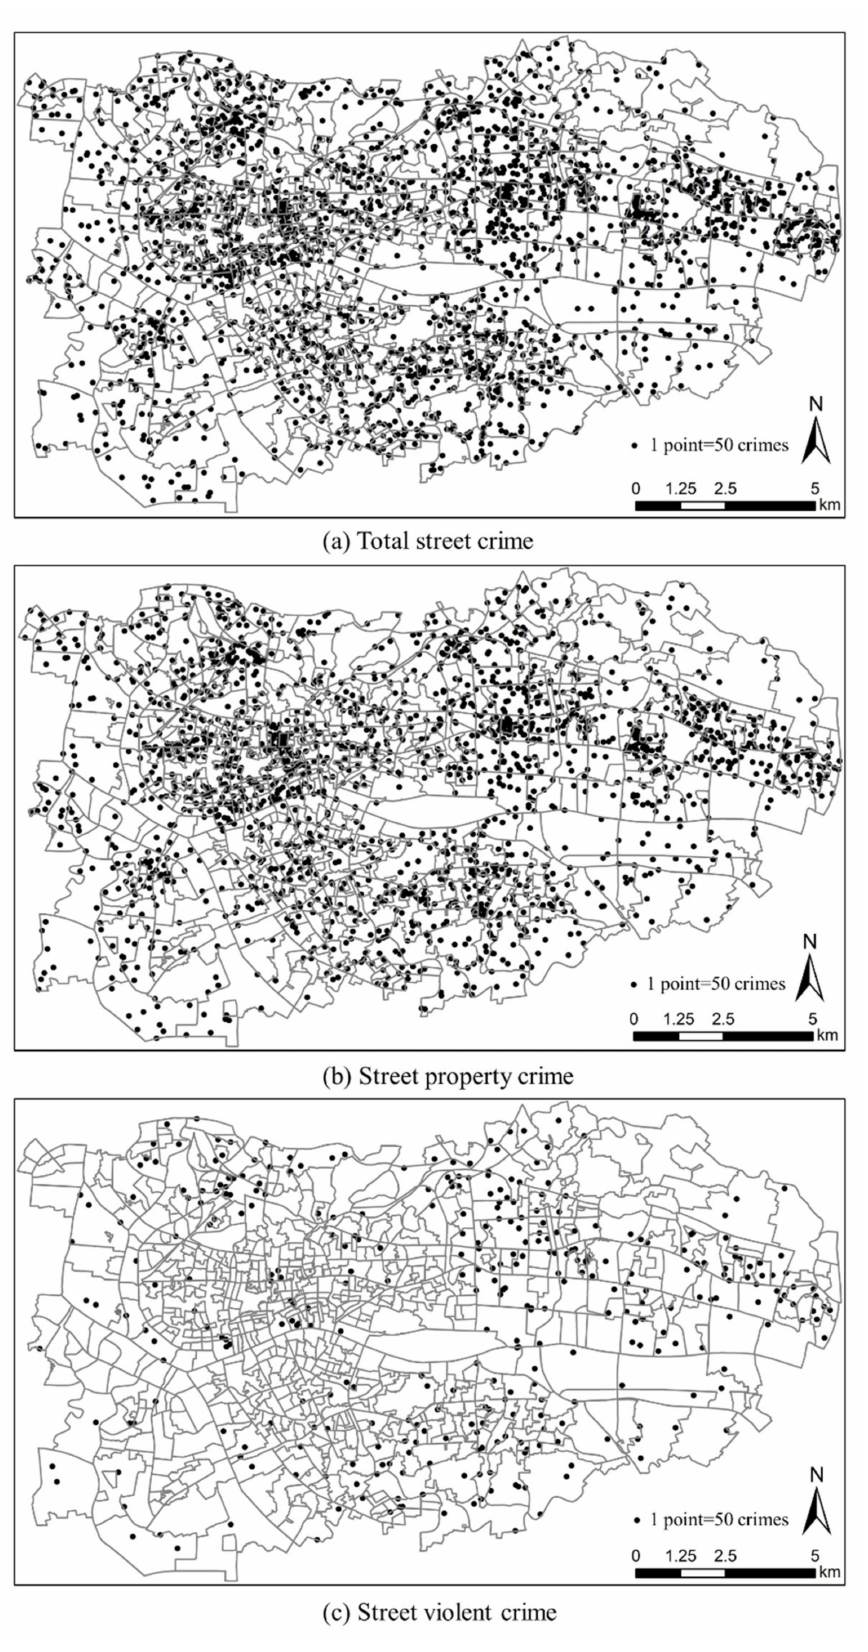
Figure 1. Dot density maps showing spatial distribution of the number of ( a – c ) in the study area as of 2017–2019. Dots were randomly placed in a